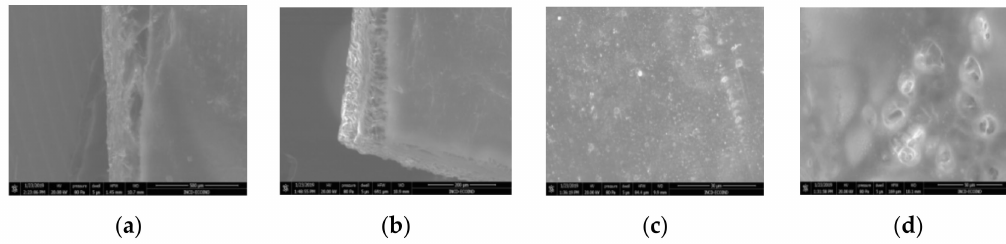
Figure 10. Polysulfone membrane (independent validation analysis): ( a )—Upper active layer (section), ( b )—bottom active layer (section), ( c )—surface and ( d )—back surface (bottom surface).